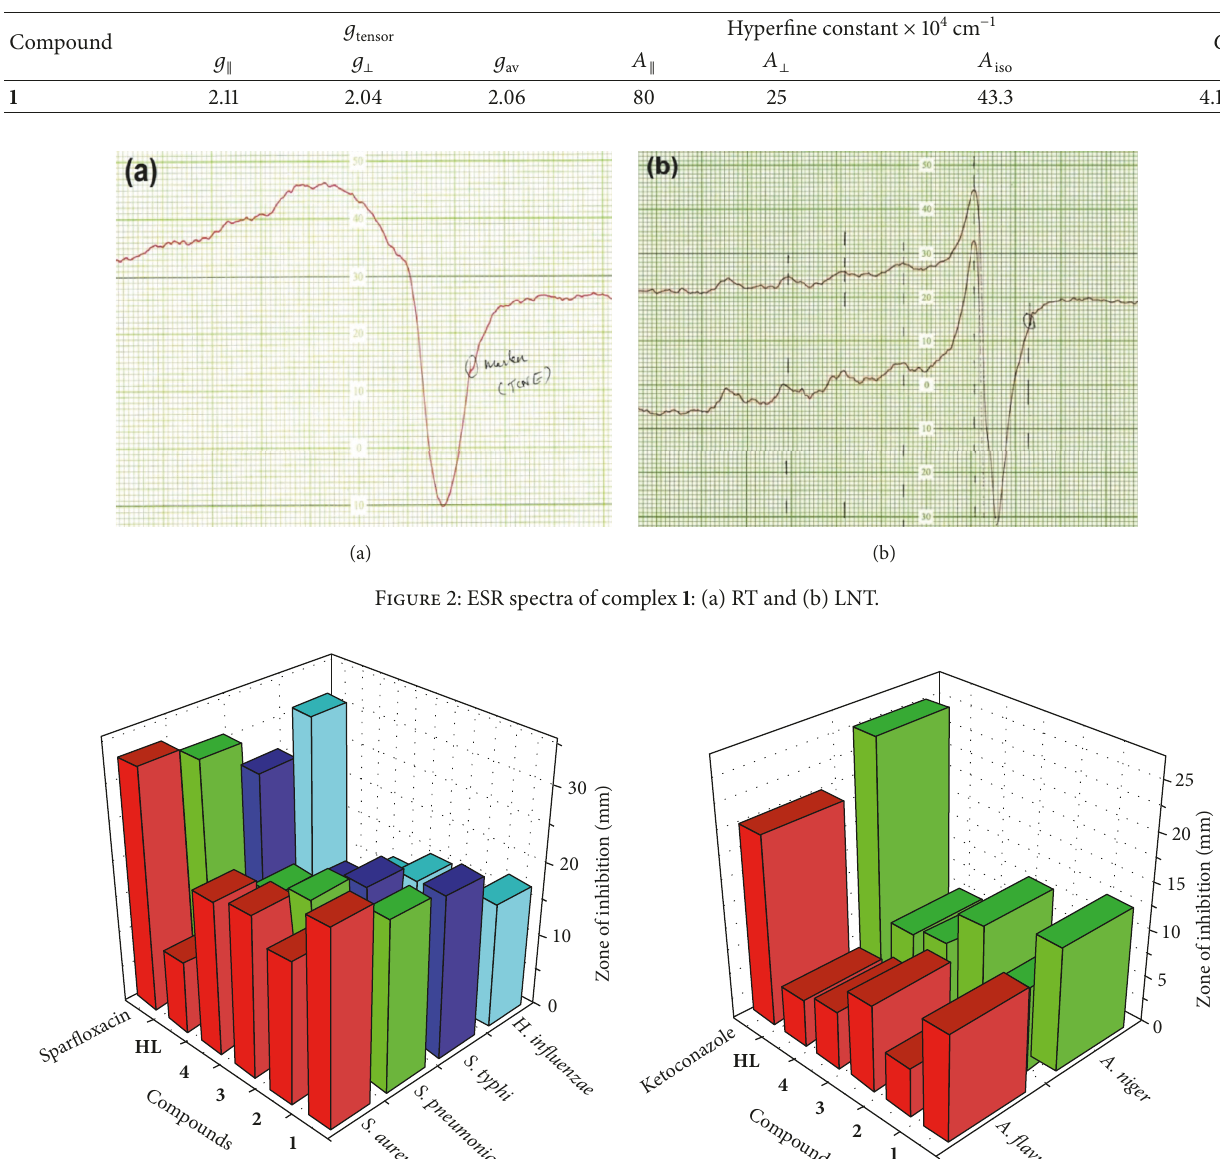
good antifungal activity compared to HL and complexes